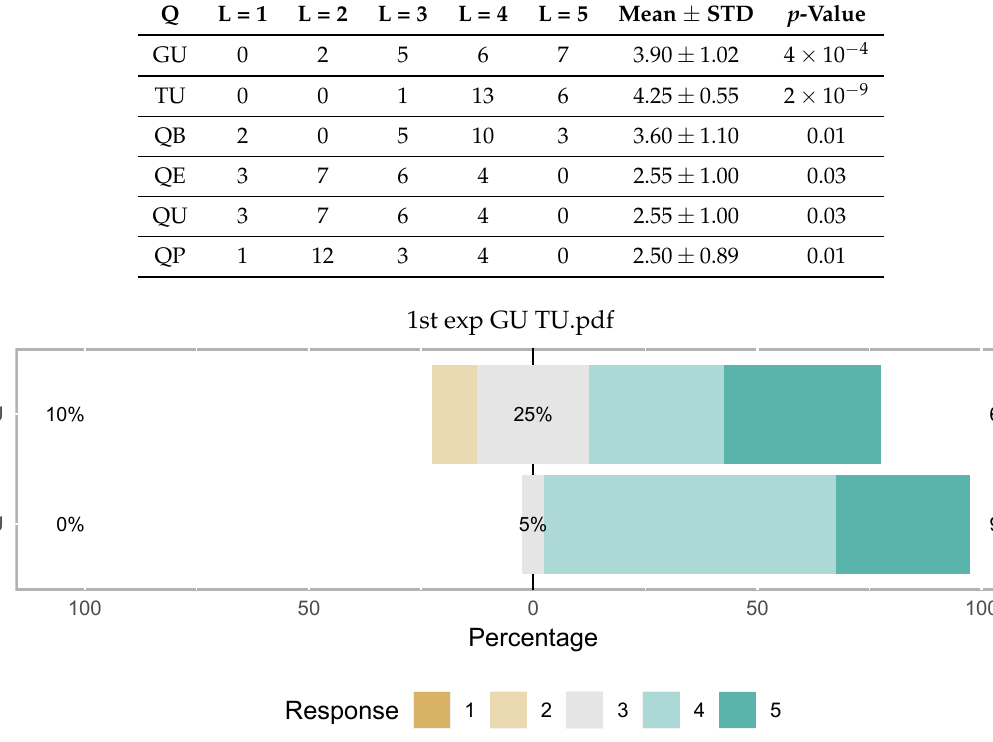
Figure 9. A graphical representation of the distribution of the answers to the questions GU and TU in Experiment